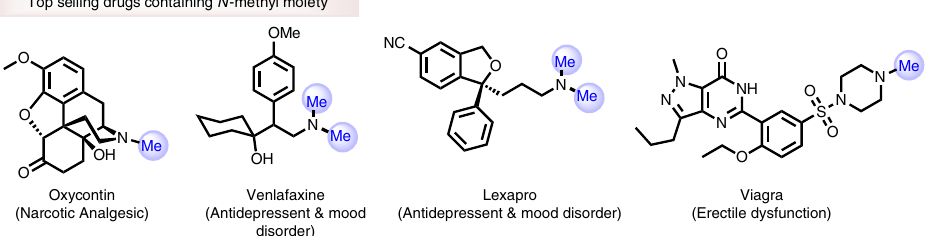
Fig. 1 Top selling drugs: Selected important drugs containing N-methyl